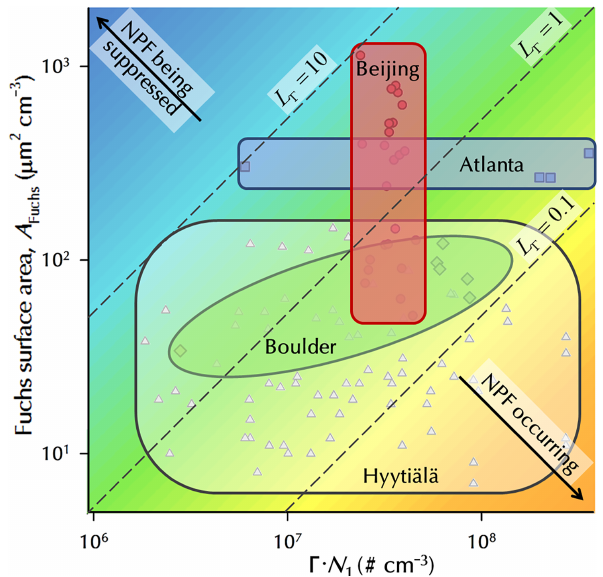
Figure 7. The schematic of governing factors for L (cid:48) at different locations. Concentration of growth relevant gaseous precursors is represented by (cid:48) × N 1 , where (cid:48) is the growth enhancement factor and N 1 is the sulfuric acid number concentration. Background color represents the magnitude of L (cid:48) . Data for each location are shown as different symbols (circle: Beijing; square: Atlanta; diamond: Boul- der; triangle: Hyytiälä). The ellipse and the boxes were artificially drawn to illustrate the variations. Tecamac was not included due to the lack of data on non-event days. Both axes are in log